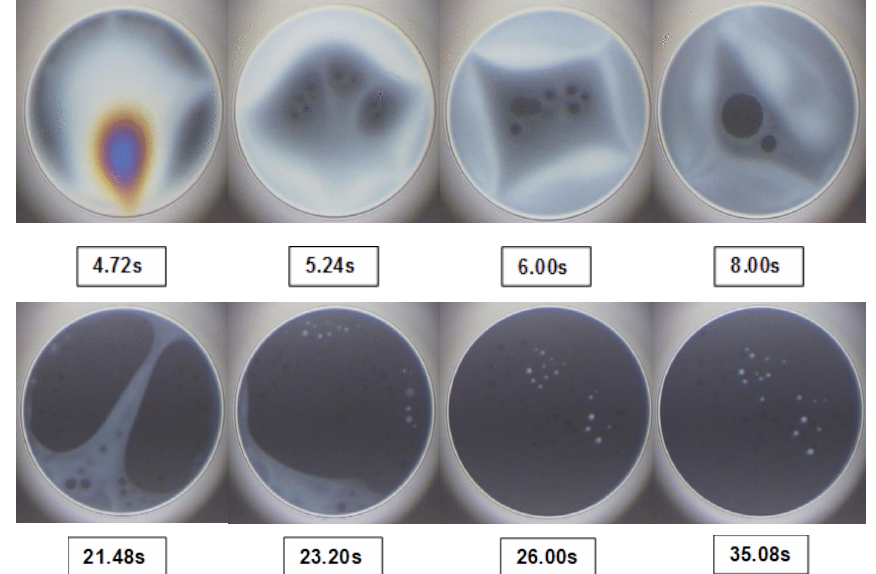
Figure 5. Critical film thicknesses of aqueous solutions of mol:mol = 1:1 CTAC/C 12 E 5 mixtures against the total surfactant concentration (C mix ). The films rupture at thickness in the range of 17–40 nm. Test values for the 1:10 and 10:1 CTAC/C 12 E 5 solutions at C mix = 3.0 × 10 −5 mol/L are presented. Typical snapshots from the evolution of a foam film obtained from the CTAC/C 12 E 5 mixture (1:1) at the total surfactant concentration of 3.0 × 10 −5 mol/L, which is above the CMC mix (2.0 × 10 −5 mol/L), are shown in Figure 6. Three well-distinguished thickness regions are observed: background black regions with thickness ~20 nm, darker black spots with thickness ~17 nm, and white dots. The latter Figure 6). Two di ff erent thickness regions—background black film and white dots—are also recorded. represent film portions of a higher thickness. The white dots usually move slowly within the film, Although the film lifetimes are slightly longer, the films finally rupture in about 1–2 min. coalesce upon contact, and disappear via draining slowly into the surrounding thinner regions.